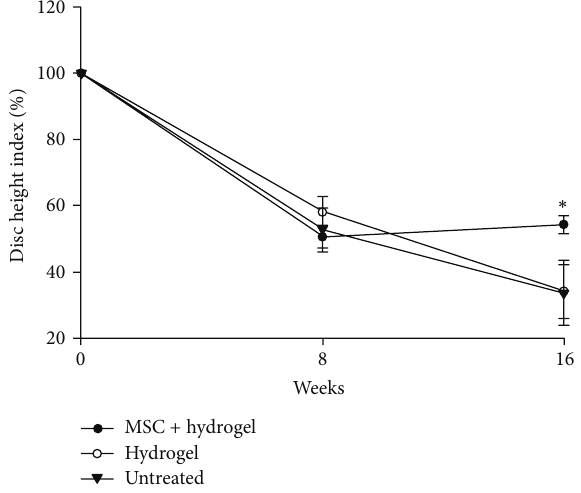
Figure 7: Nucleus pulposus disc height index. Values obtained at each point are normalized to preoperative score at day “0” (100%). ∗ indicates significance at 𝑃 < 0.05